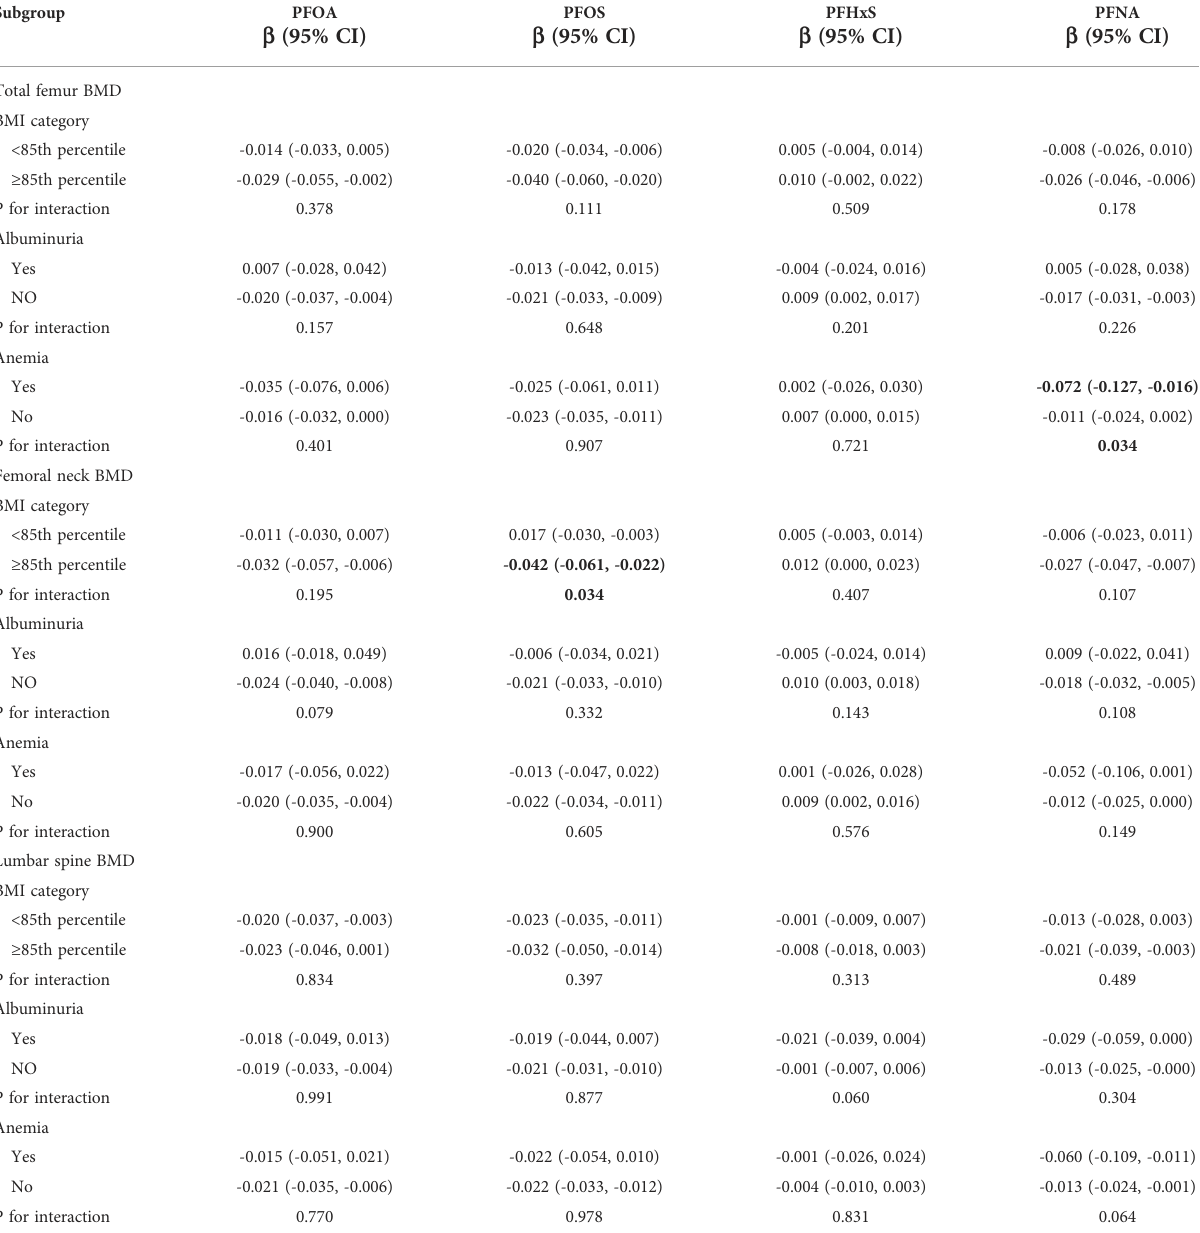
TABLE 3 Association between PFAS concentration and BMD, strati fi ed by BMI groups, albuminuria (yes/no), and anemia (yes/no).